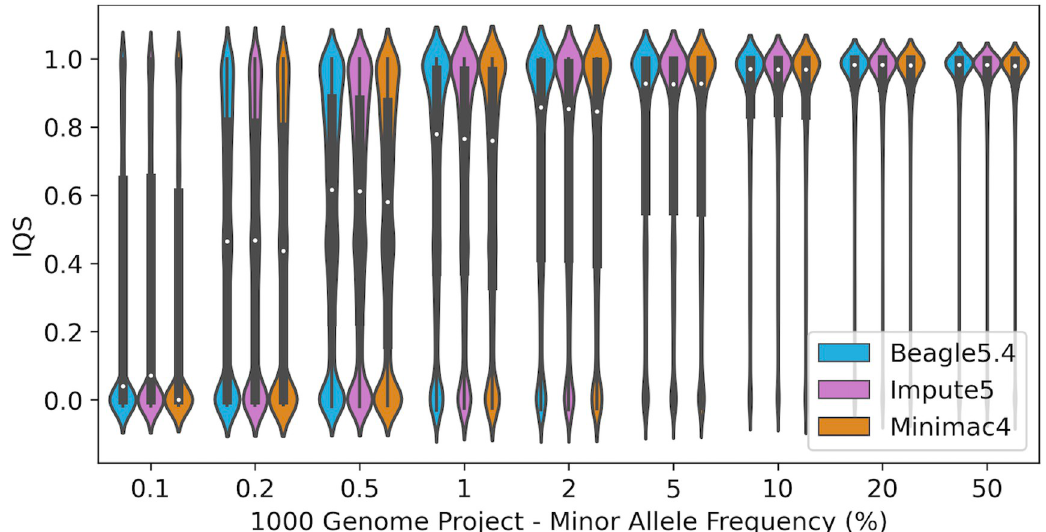
Fig 10. Evaluation of rare variants imputation. Violin plot of IQS against minor allele frequency (MAF) in the EBB dataset.